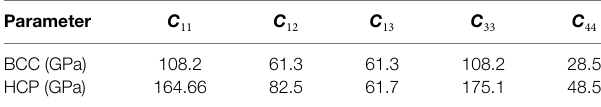
TABLE 4 | Elastic constants for HCP and BCC crystals. TABLE 5 | Slip system of HCP and